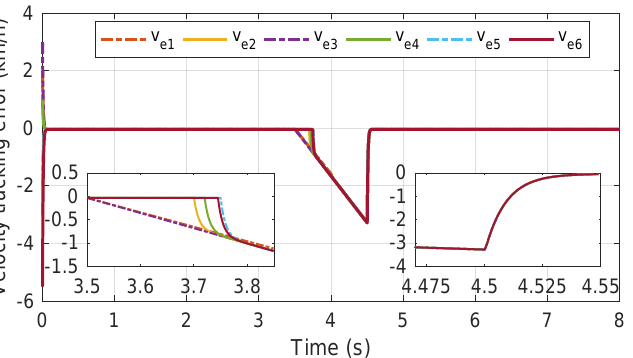
Figure 9. Velocity tracking error curve of each carriage with the proposed consensus braking controller in case 2.